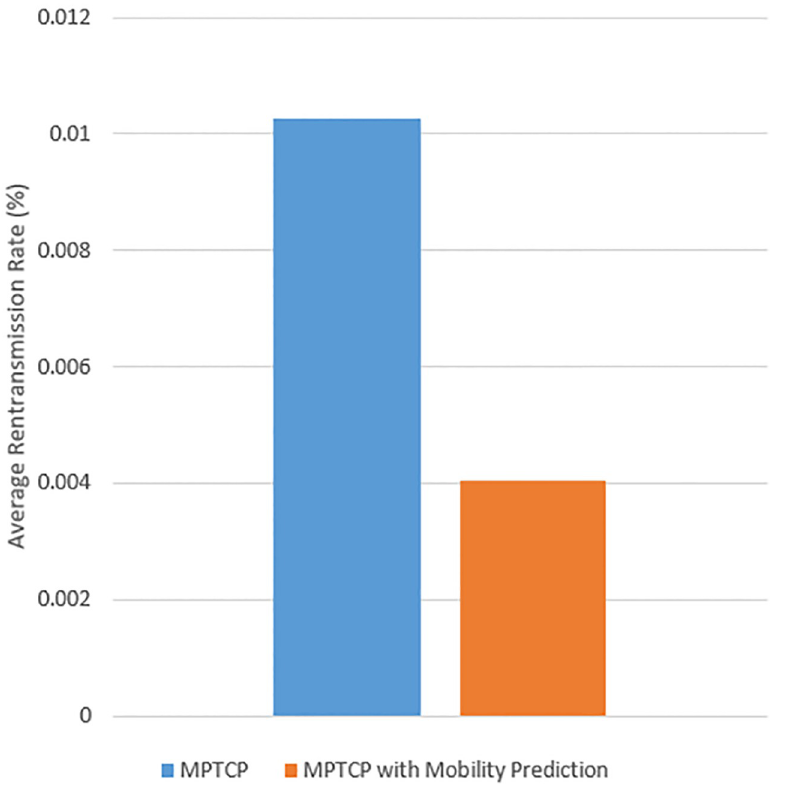
Fig 28. The average retransmission rate using MPTCP and MPTCP with mobility